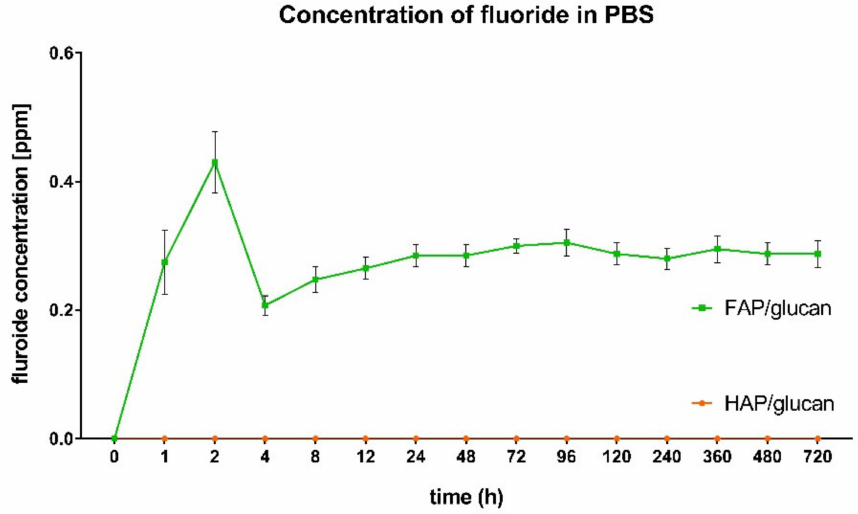
Figure 7. Fluoride release profile from the composite materials to PBS medium with a pH 7.4. The HAP/glucan composite did not release fluoride into the